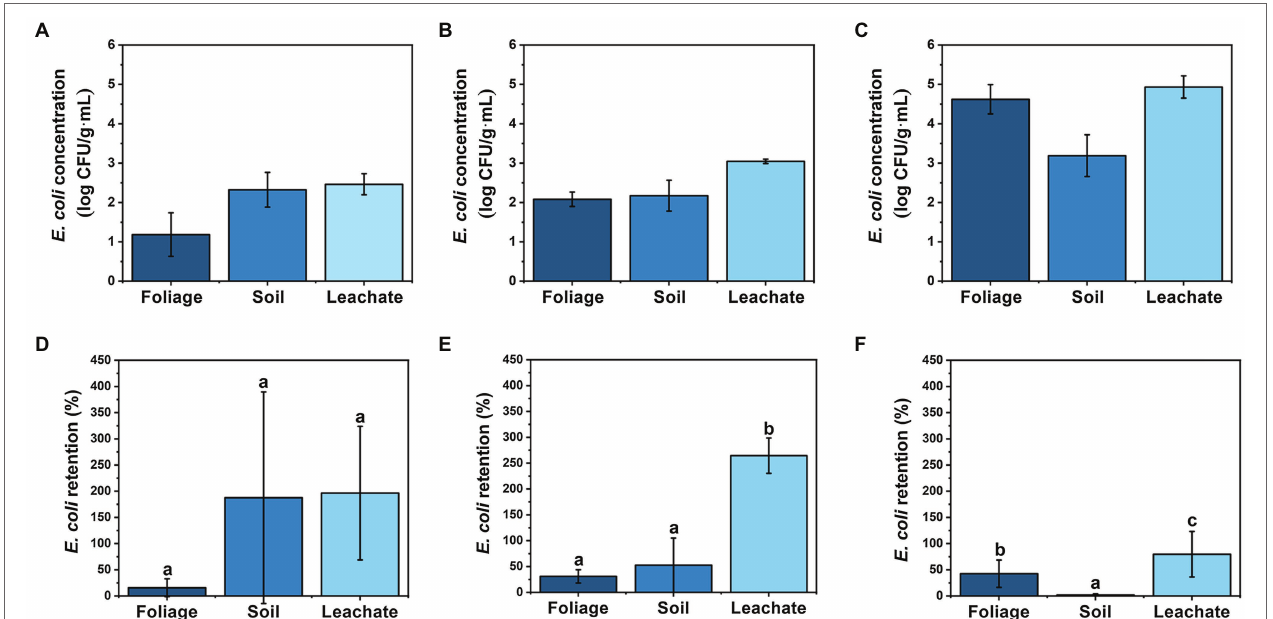
FIGURE 2 | Comparison of E. coli concentration at (A) day 0, (B) day 7, and (C) day 14 in log CFU g −1 or log CFU ml −1 (wet weight basis) and retention on (D) day 0, (E) day 7, and (F) day 14 in % for foliage, soil, and leachate samples, respectively. Retention was calculated by dividing E. coli sample concentration (CFU ml −1 or CFU g −1 ) by weekly E. coli irrigation water concentration (CFU ml −1 ). Moisture content of foliage = 91.3% and soil = 4.44%. Sample sizes: wastewater = 10 ml, leachate = 10 ml, foliage = 5 g, and soil = 2 g. Error bars denote standard deviation for arithmetic mean ( n = 6 for day 0 foliage and n = 12 for all others). Different letters indicate statistical difference using Tukey-Kramer HSD, α =